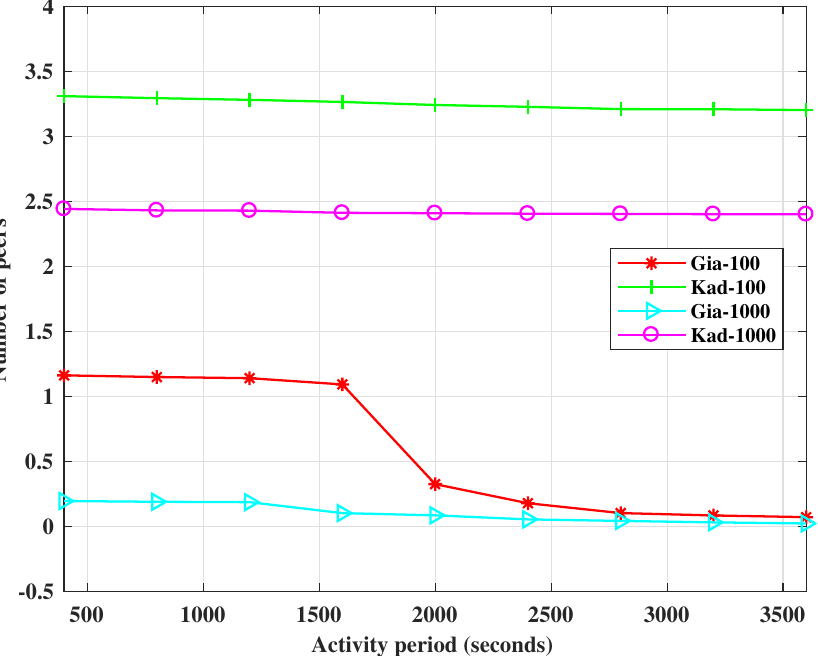
Figure 3. Number of peers transversed to discover a resource in the